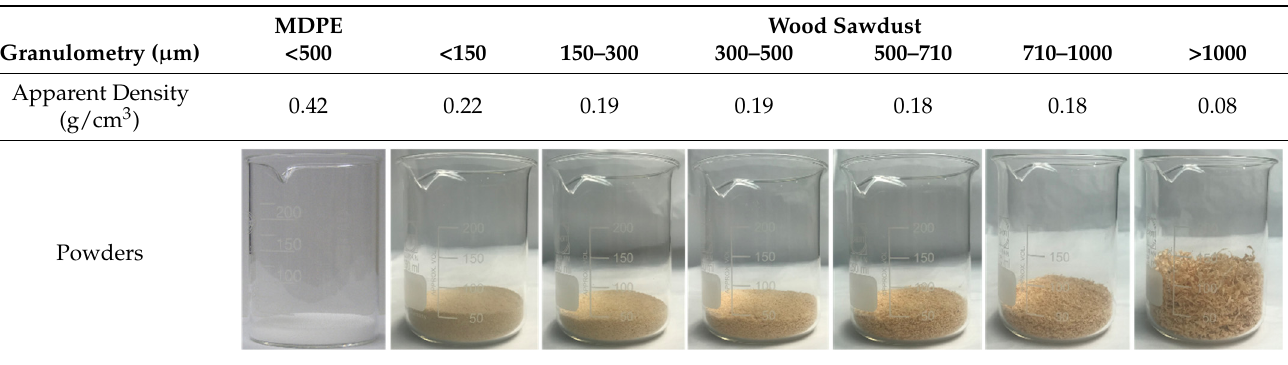
Table 1. Apparent density of MDPE and wood with different granulometries. Images correspond to 10 g of each material.